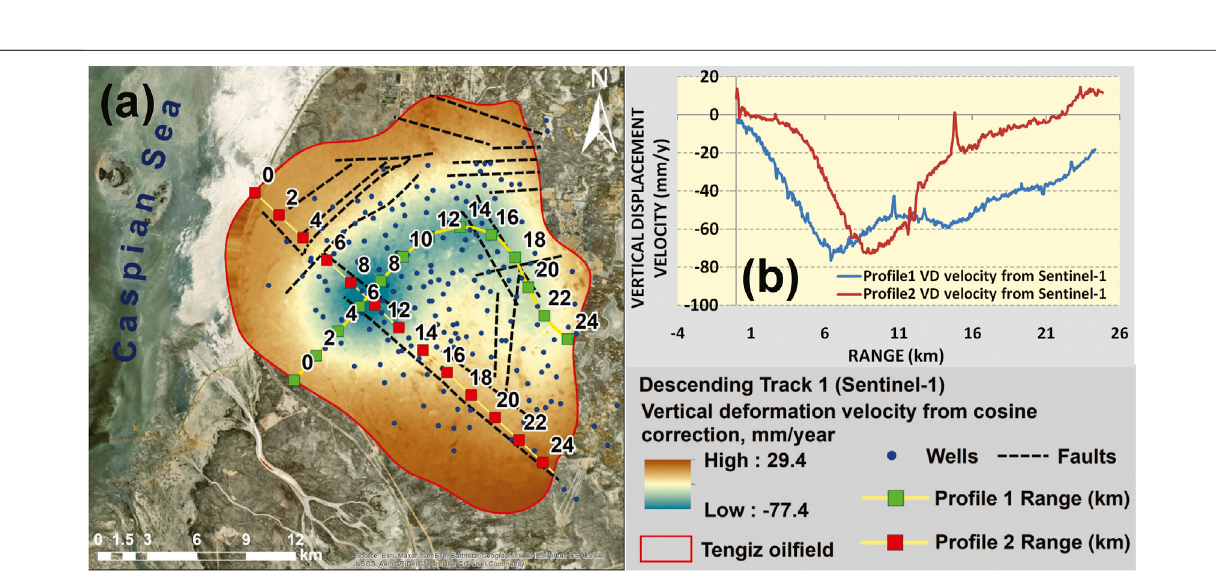
Frontiers in Environmental Science |